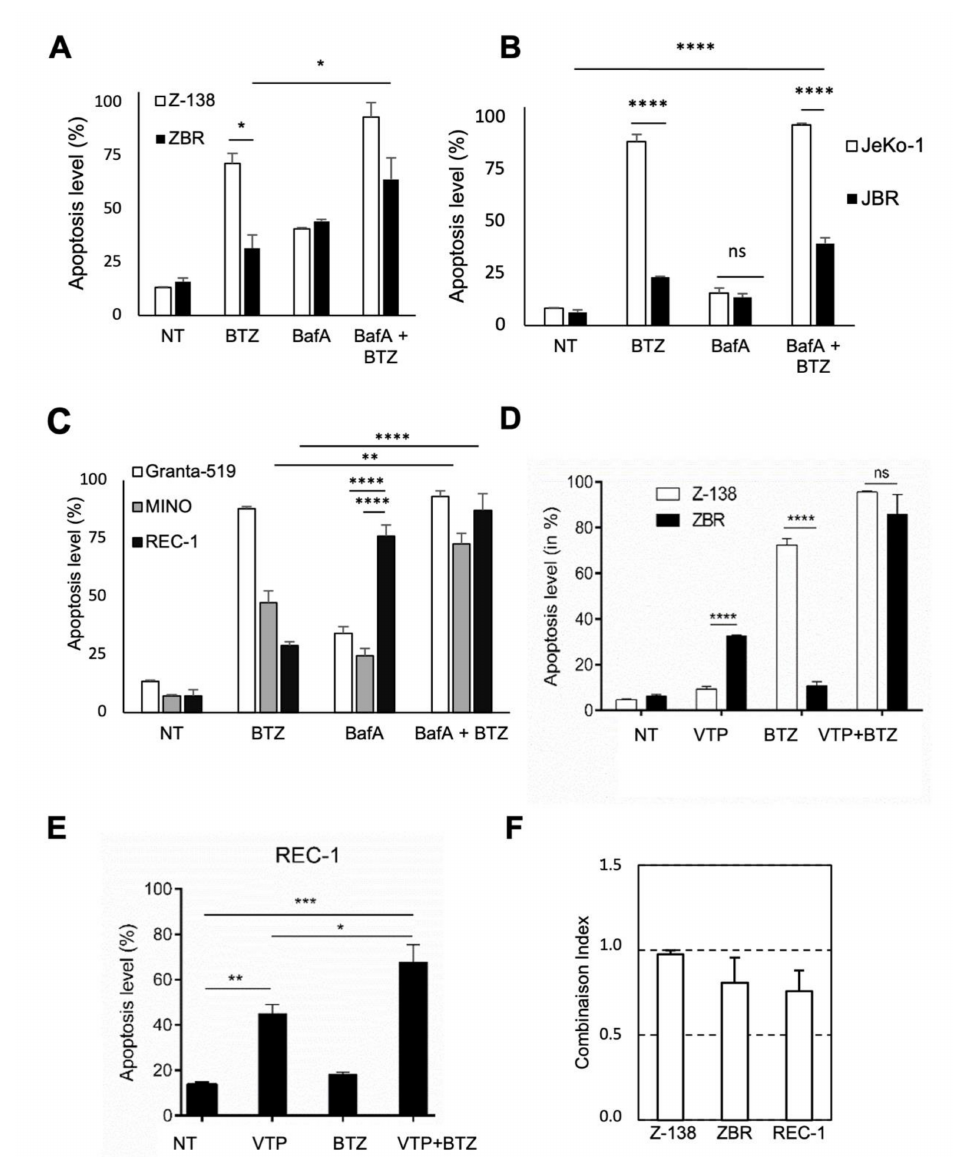
Figure 5. Autophagy inhibition increases apoptosis of BTZ-resistant cells. Flow cytometry analysis of apoptosis in Z-138 and ZBR cells ( A ), JeKo-1 and JBR ( B ) cells or in Granta-519, MINO and REC-1 ( C ) MCL cells treated or not treated for 48 h with 10 nM BTZ, 50 nM BafA or a combination of the drugs, as indicated. Apoptosis levels were measured by annexin V staining in Z-138 and ZBR cells ( D ) treated for 24 h with 5 µ M VTP, 5 nM BTZ or the combined treatment and in REC-1 cells ( E ) treated for 24 h with 15 µ M VTP, 5 nM BTZ or the combined treatment ( n ≥ 3; means ± SD; two-tailed Student’s t -test, * p < 0.05, ** p < 0.01, *** p < 0.001, **** p < 0.0001). ( F ) From these results, we calculated the combination indexes (CIs) for Z-138, ZBR and REC-1 treated with VTP or BTZ using the